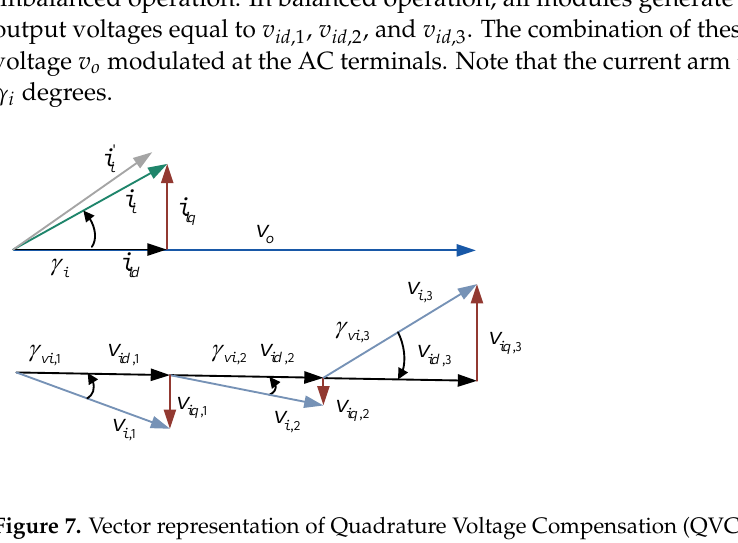
Figure 7. Vector representation of Quadrature Voltage Compensation (QVC). When there is an energy difference, all modules adjust their output voltages to with- stand the power imbalance. After the QVC is used, the output voltages become v i ,1 , v i ,2 , and v i ,3 . These new values are generated by introducing the quadrature voltages v iq ,1 , v iq ,2